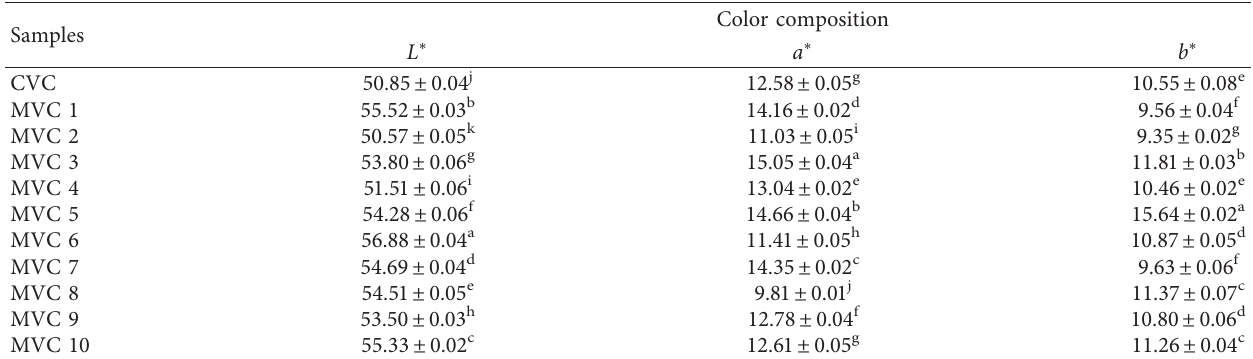
Table 2: Color composition of village chicken meat obtained from a genuine supplier and 10 different markets. Samples